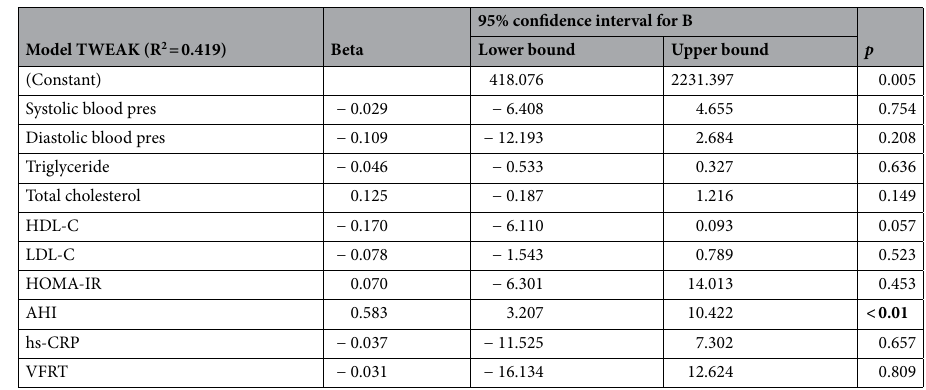
Table 2. Evaluation of the relationship of TWEAK variable with other parameters by multiple regression analysis. Significant values are in bold. Variables included in the model: age, GDM (no/yes), family history of T2DM, previous GDM, systolic and diastolic blood pressure, HDL cholesterol, TG, prepregnancy BMI, sTWEAK. Variables included in the model; TWEAK Tumor necrosis factor (TNF)-like weak inducer of apoptosis, HDL-C High-density lipoprotein cholesterol, LDL-C Low-density lipoprotein cholesterol, HOMA-IR Homeostasis model of assessment-insulin resistance, AHI Apnea/hypopnea index, hs-CRP high sensitivity C-reactive protein, VFRT Visceral fat